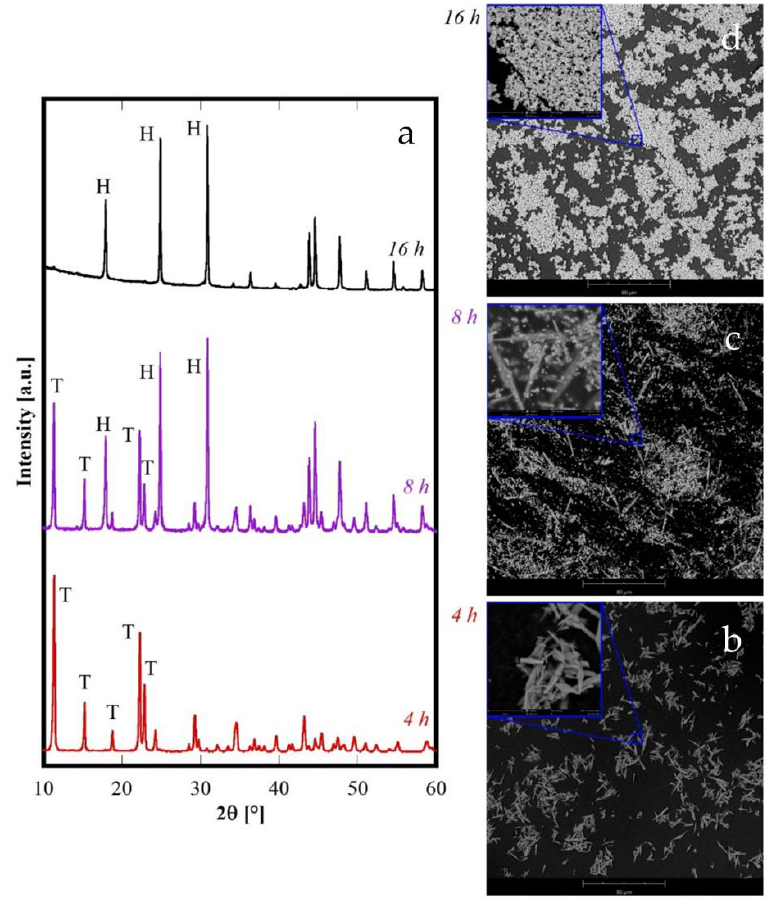
Figure 8. Di ff raction patterns ( a ) and SEM micrographs of samples containing Nd synthesized at various durations: 4 h ( b ), 8 h ( c ) and 16 h ( d ). T stands for tengerite phase and H stands for hexagonal- hydroxycarbonate.